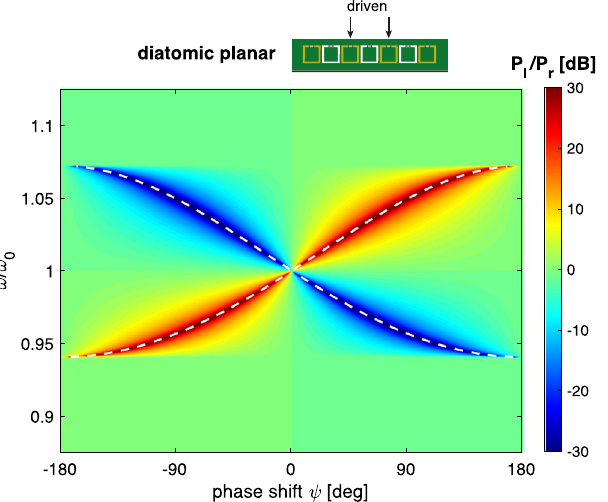
exp ( j ψ) and V 15 1 ) of a planar array = = 27 . Lossless case. White dashed line =